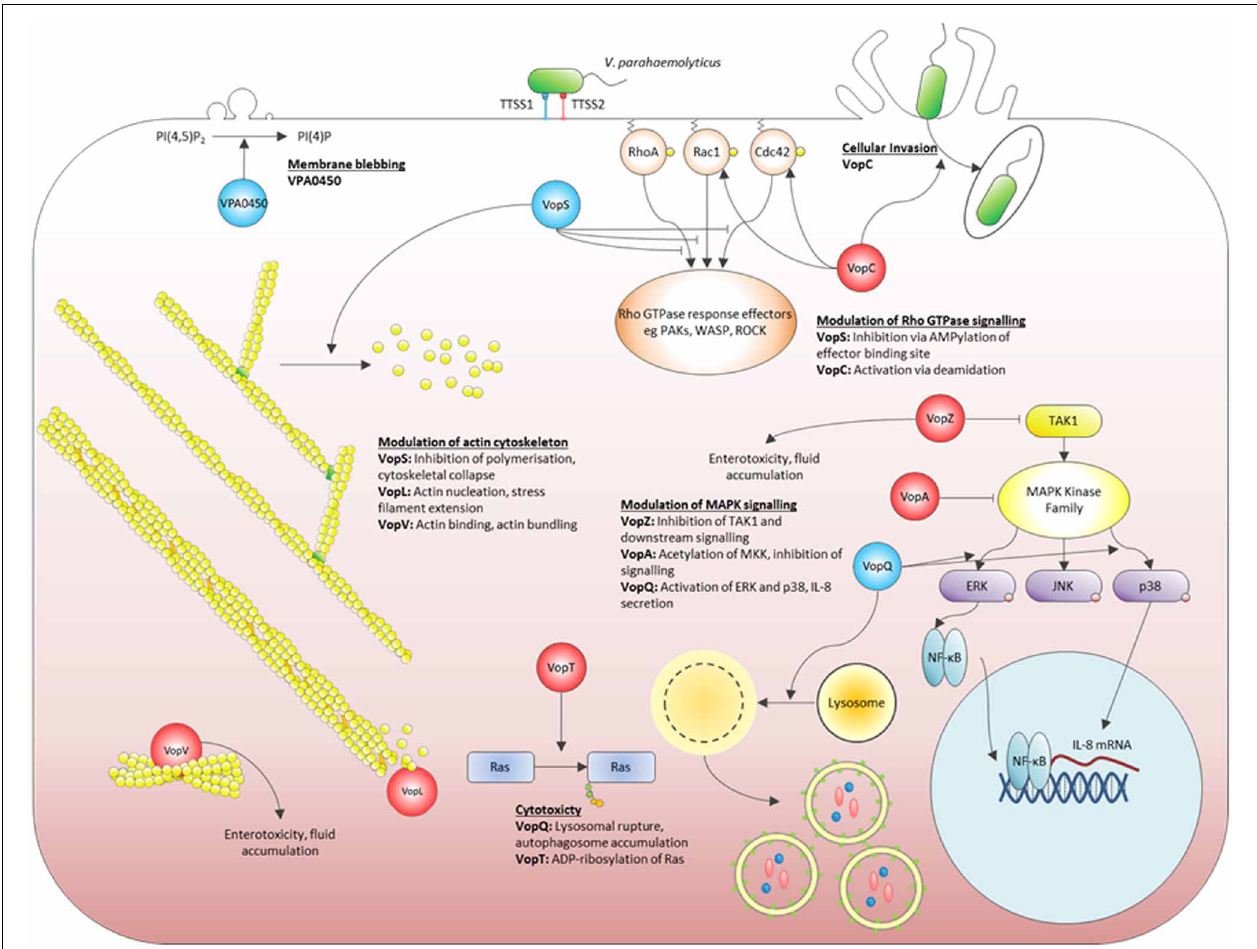
FIGURE 2 | Activity of the V. parahaemolyticus TTSS effectors in intestinal epithelial